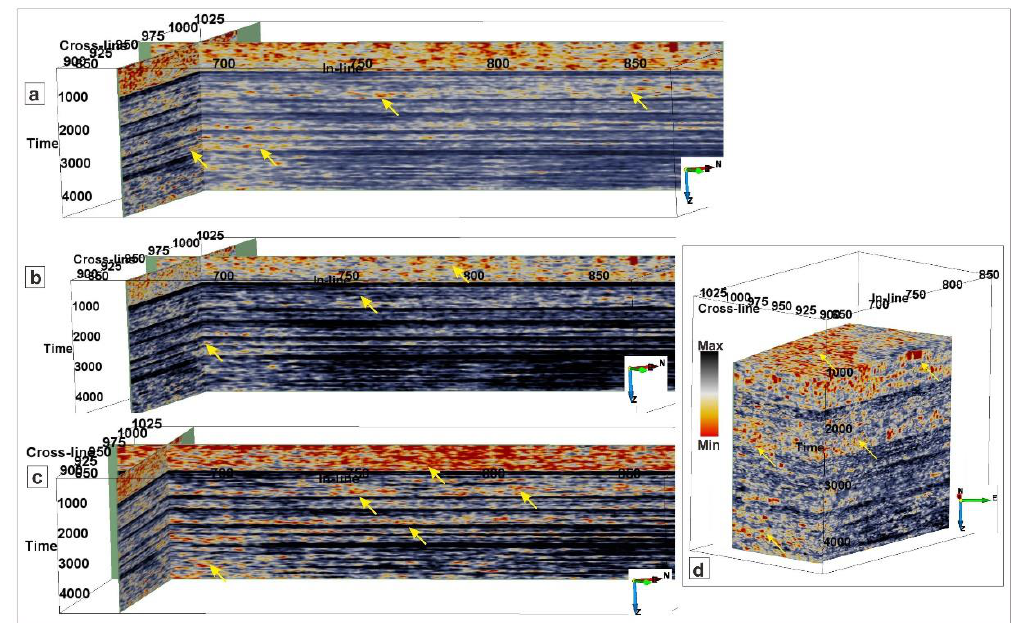
Figure 6. Seismic sections showing the major discontinuities: ( a ) full-steered similarity, ( b ) non-steered similarity, and ( c ) FEF-similarity attributes. The FEF-similarity gave the best results. ( d ) FEF-similarity cube. The yellow arrows represent major discontinuities.